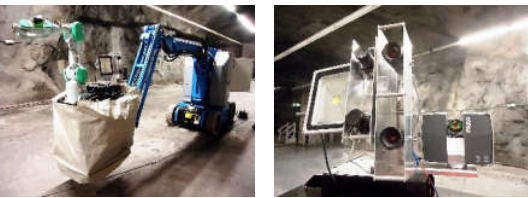
Figure 2. Images of the first functional prototype robotic vehicle for tunnel inspection. Left image: an overall image of the autonomous vehicle, the robotic arm and the imaging system; right image: the robot’s sub-system of sensors, the cameras and the laser scanner.